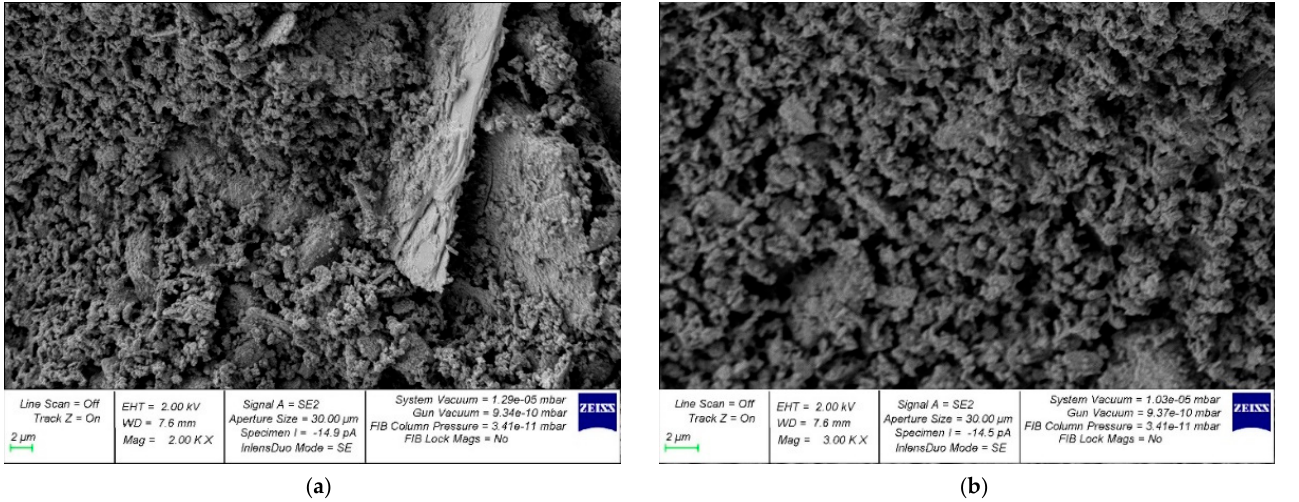
Figure 12. Microstructure of the geopolymer composite at the age of 28 days: ( a ) composition of type C; ( b ) composition of type 8B.